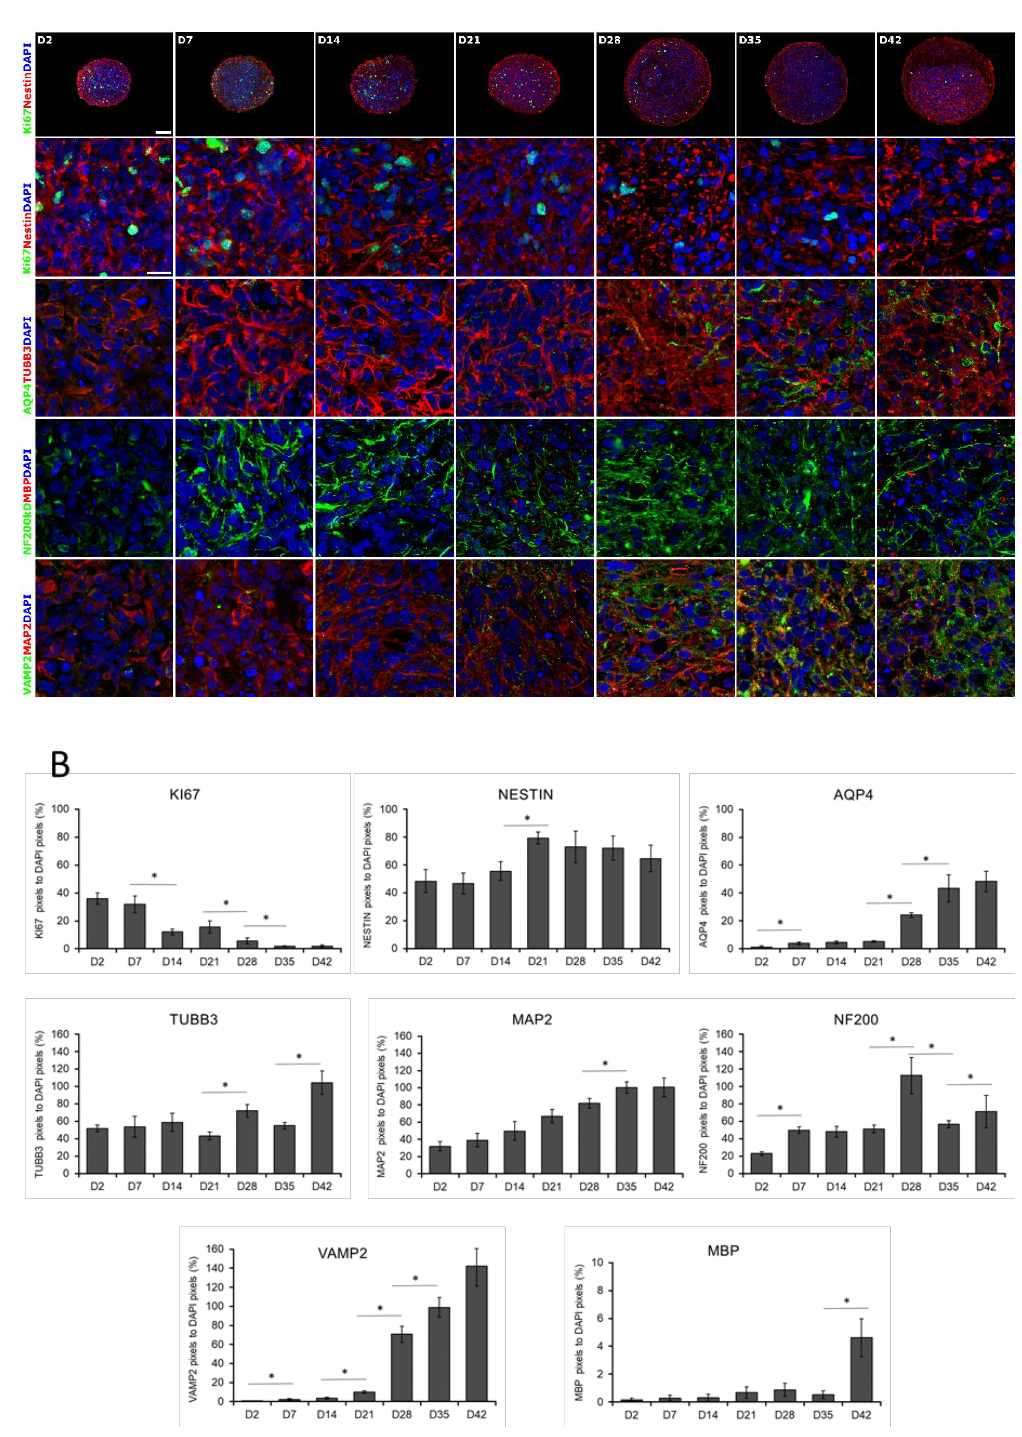
Figure 2. Immunocytochemical analysis of 3D spheroids. ( A ) Spheroids were fixed and cryosectioned then immunostained at weekly intervals from D2 until D42 stage. The first line represents the overview of the cryosectioned spheroids, while the rest of the panel shows higher magnifications. Relevant markers of proliferation (KI67), neural stem cells (NESTIN), neuronal differentiation (TUBB3 and MAP2), an intermediate filament of dendrites and axons (NF200), synaptic vesicles of neurons (VAMP2), astrocyte (AQP4), and oligodendrocyte (MBP) specific proteins were stained. Protein name IDs are indicated with colors, representing the color of the fluorophore used (e.g., green as Alexa 488; red as Alexa 594) Nuclei were counterstained with DAPI (in blue). Scale bar: 100 µ m (first line only) and 25 µ